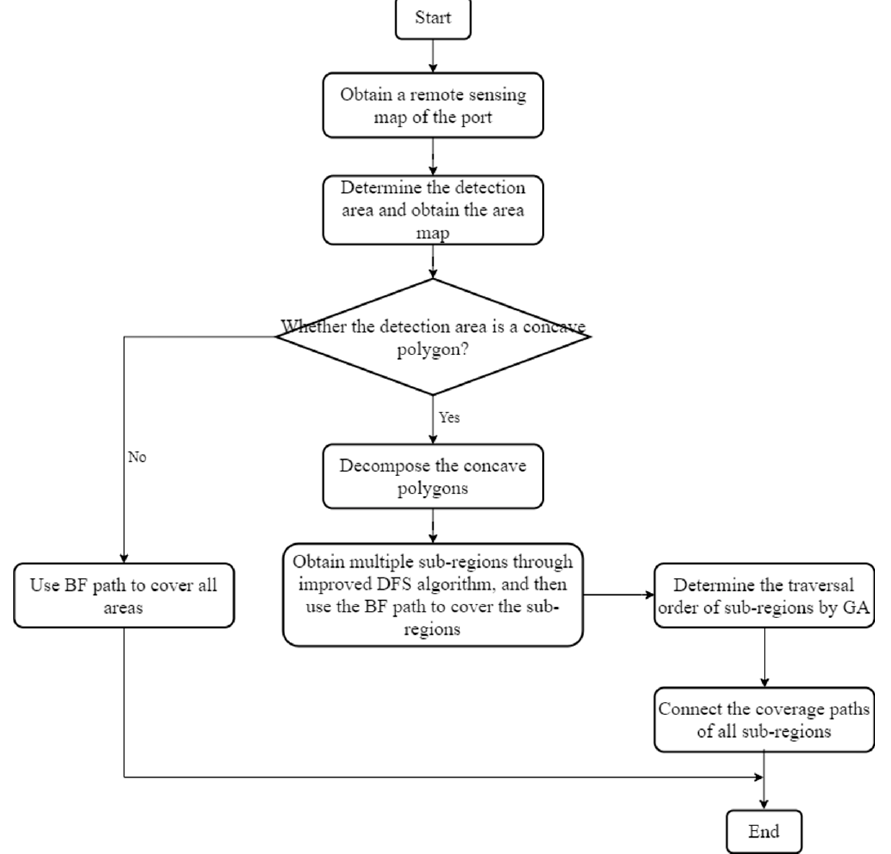
Figure 11. Flowchart of CPP for a port area.